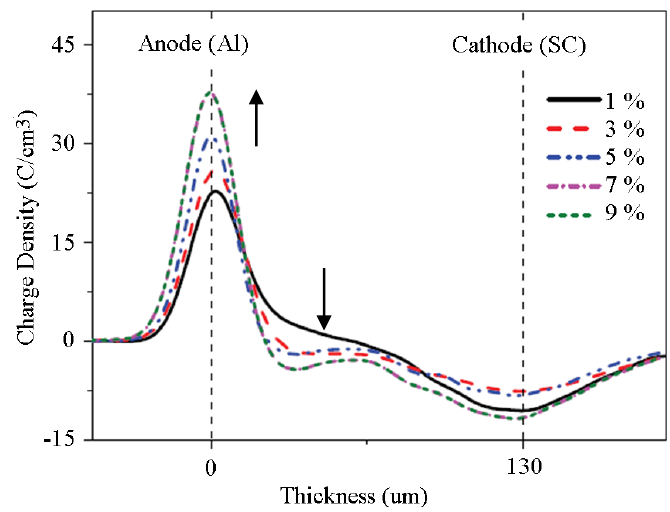
Figure 6. Space charge distribution curves of unaged samples with different moisture concentrations at the end of 30 min polarization [16].